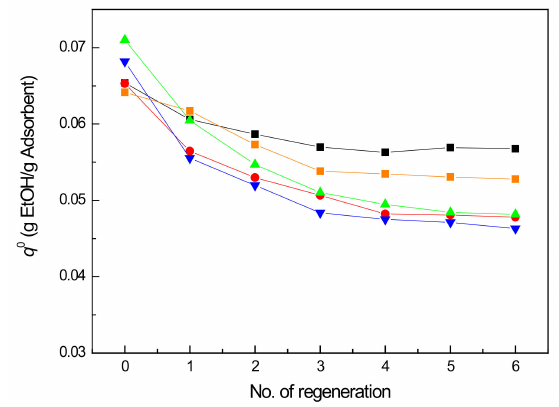
Figure 9. Efficacy of air regeneration for V r400 (black (cid:4) ), V r350 (red • ), NaY r200 (green (cid:78) ), V r400 MMA-WG (orange (cid:4) ), and NaY r200 MMA-WG (blue (cid:72)